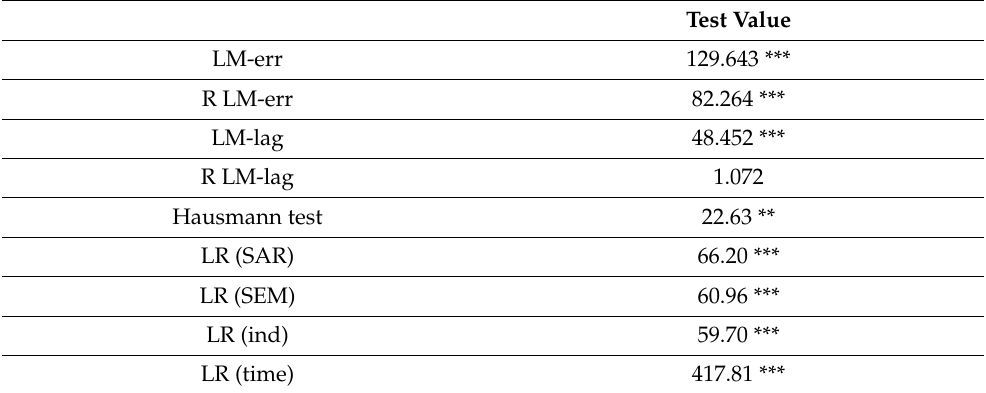
Table 2. Model selection test.